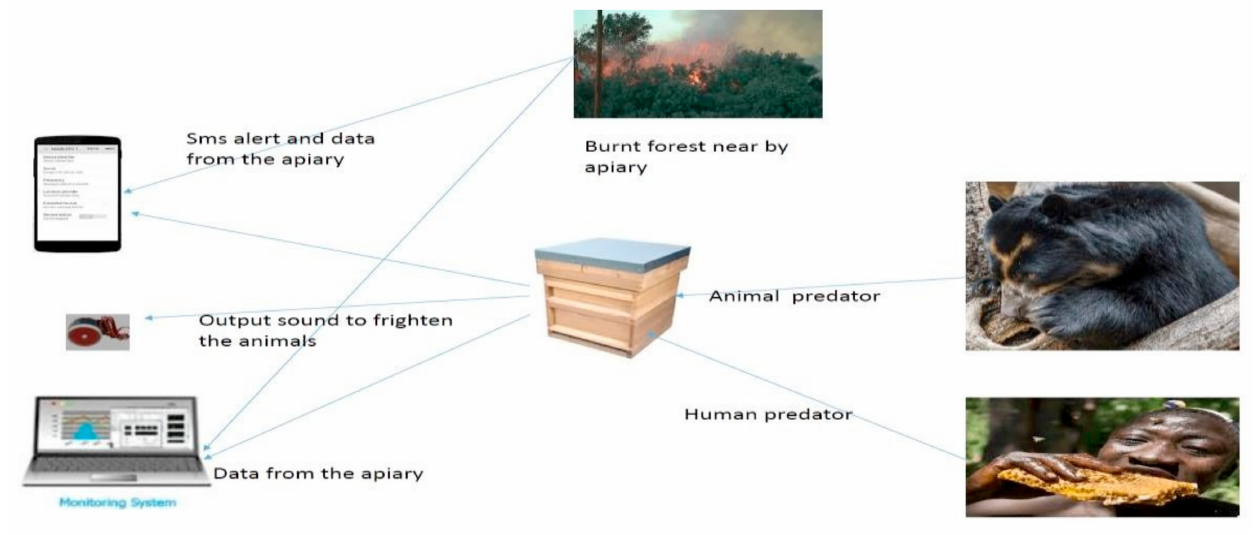
Figure 3. SBMaCS system